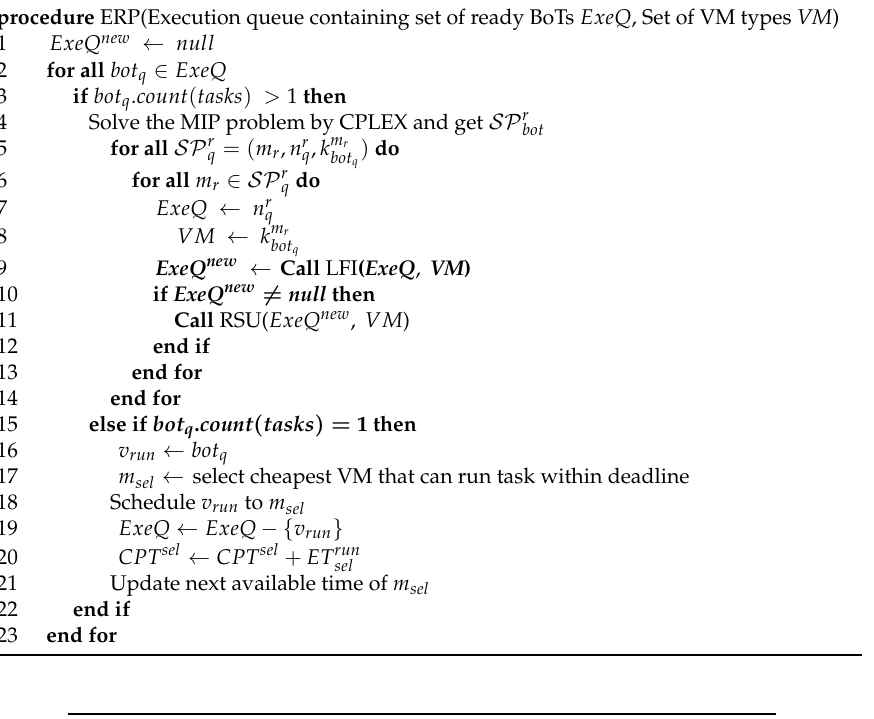
Algorithm 2 Elastic Resource Provisioning